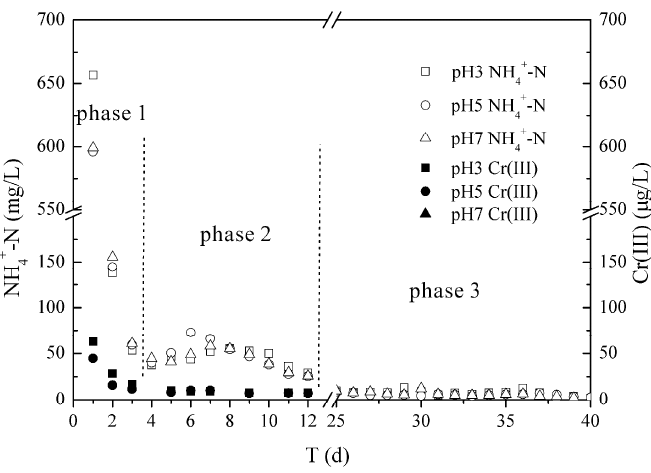
Figure 4. Leaching concentrations of Cr(III) and NH 4+ -N under different leachate pH.